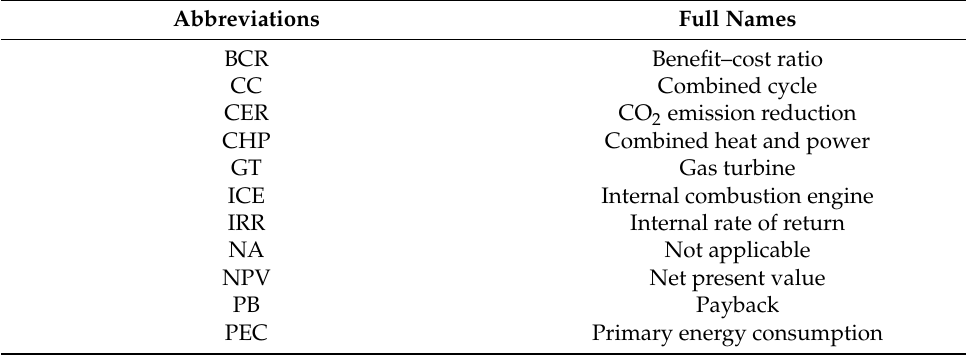
Table 2. A list of all abbreviations and their corresponding full